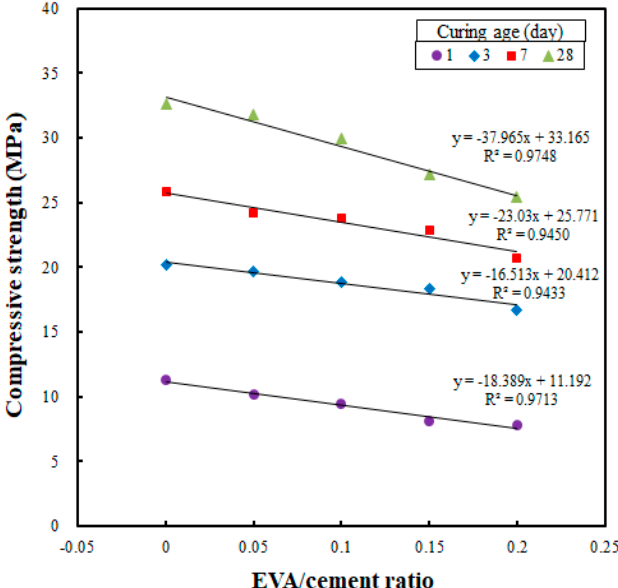
Figure 5. Relationship between EVA / cement ratio and compressive strength for printed specimens at di ff erent curing ages.